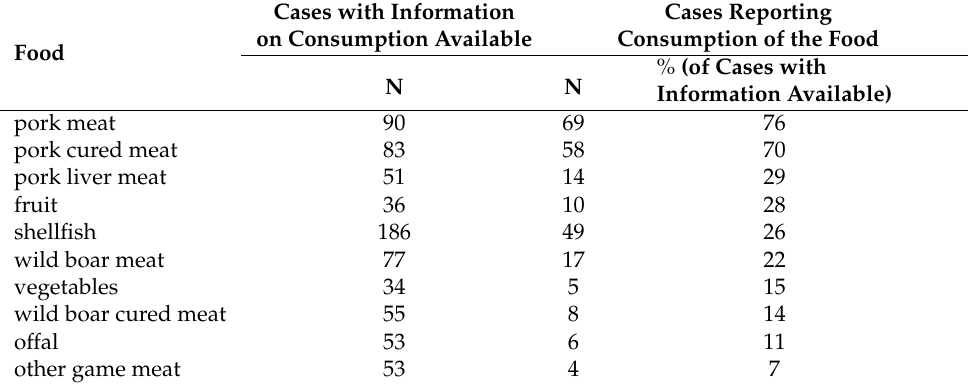
Table 11. Information on food consumption among hepatitis E cases reported between 2016 and 2019 to the Italian surveillance system for acute viral hepatitis